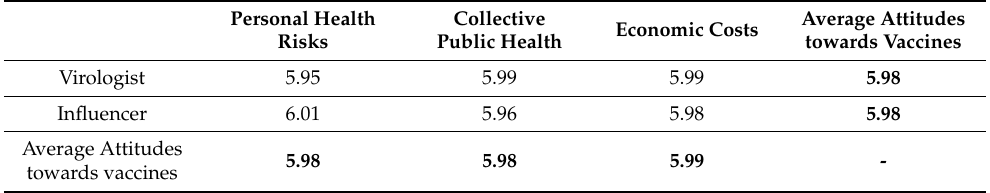
Table 5. Overall Attitudes towards